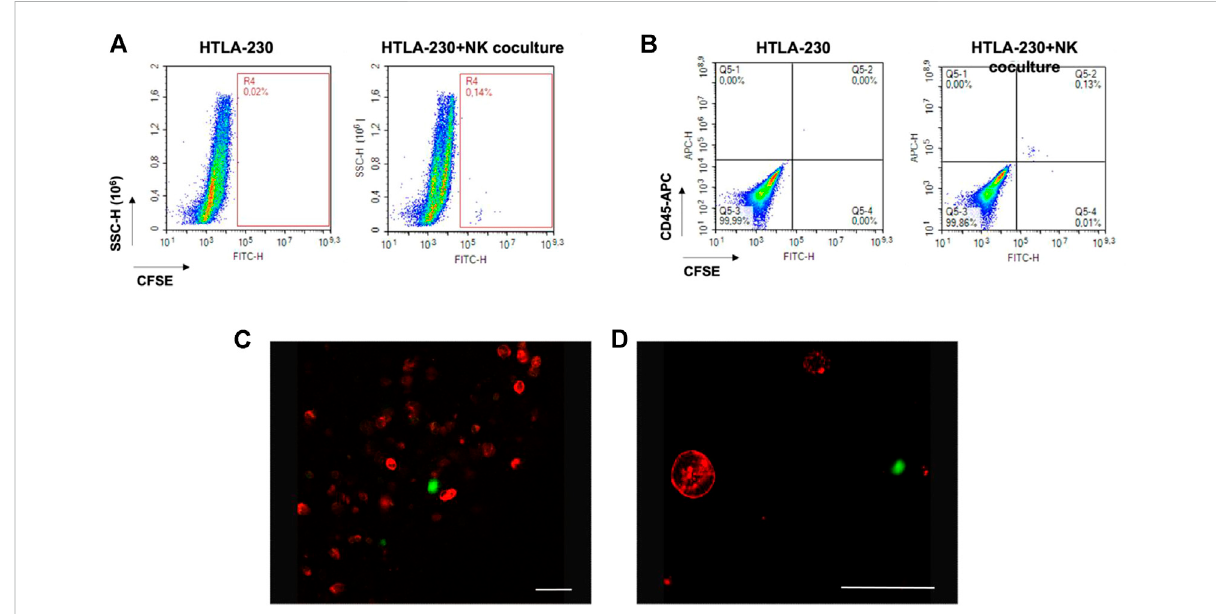
FIGURE 7 Over/night dynamic co-culture of alginate-embedded neuroblastoma cells with circulating NK cells. (A) Representative experiment showing a fl ow cytometry analysisof thecells recovered fromthe gels.A clearpopulation of CFSE-labelled cells (corresponding to NK cells) isvisible inthe co- cultured sample ( n = 6). (B) Perfect concordance between CFSE-labelling and CD45 expression ( n = 6). (C and D) Confocal Analysis of different 3D alginate scaffold isolated from 3D dynamic cultures (4 h). Representative confocal microscopy xy fi elds (370 × 370 micron) acquired in 3D alginate scaffolds containing GD2-positive NB cells (red) that were previously embedded in the gel, and subjected to 4 h of dynamic fl ow of CFSE- labeled NK cells (green). Merged fl uorescence images show that NK cells were able to in fi ltrate the gel. Scale bar is 50 micron.